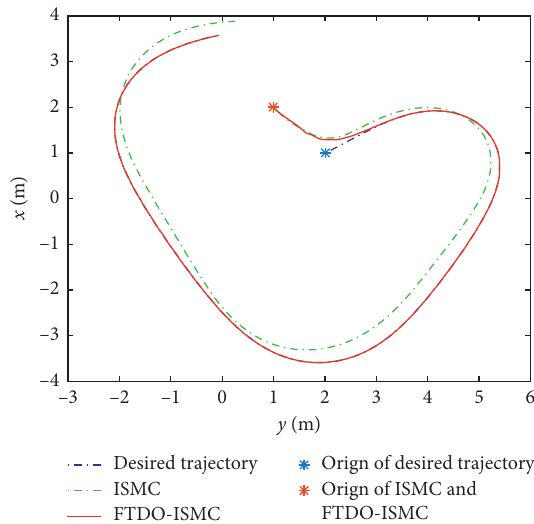
Figure 7: Planar trajectory tracking on ISMC and FTDO-ISMC.